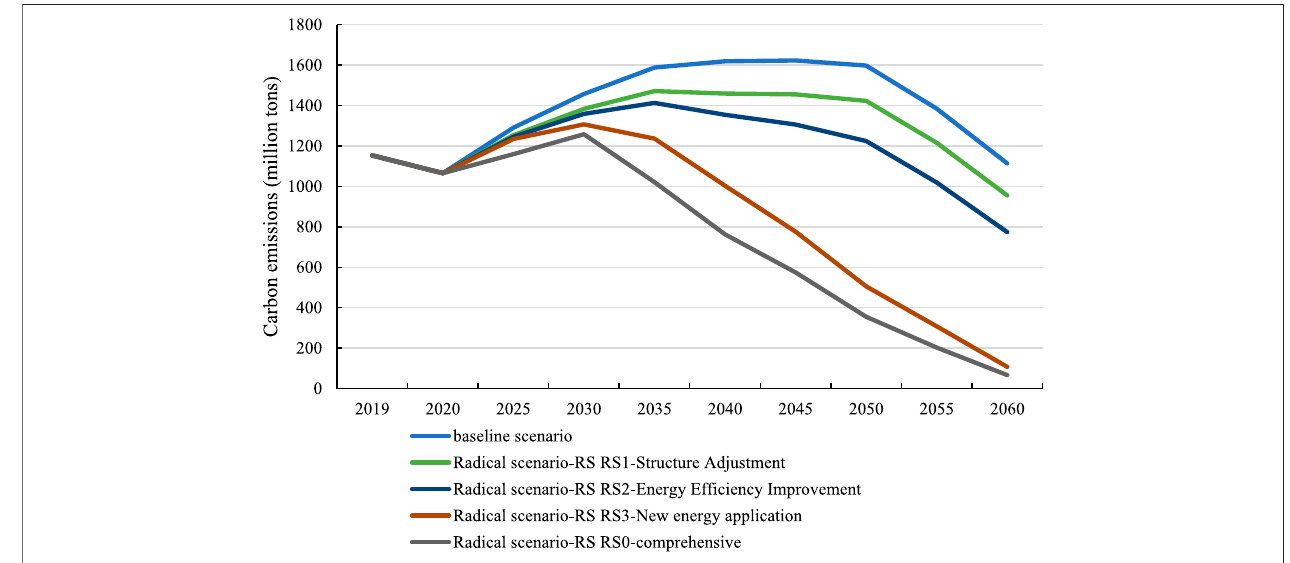
FIGURE 12 | Trends of carbon emissions with different policy measures under the radical scenario.